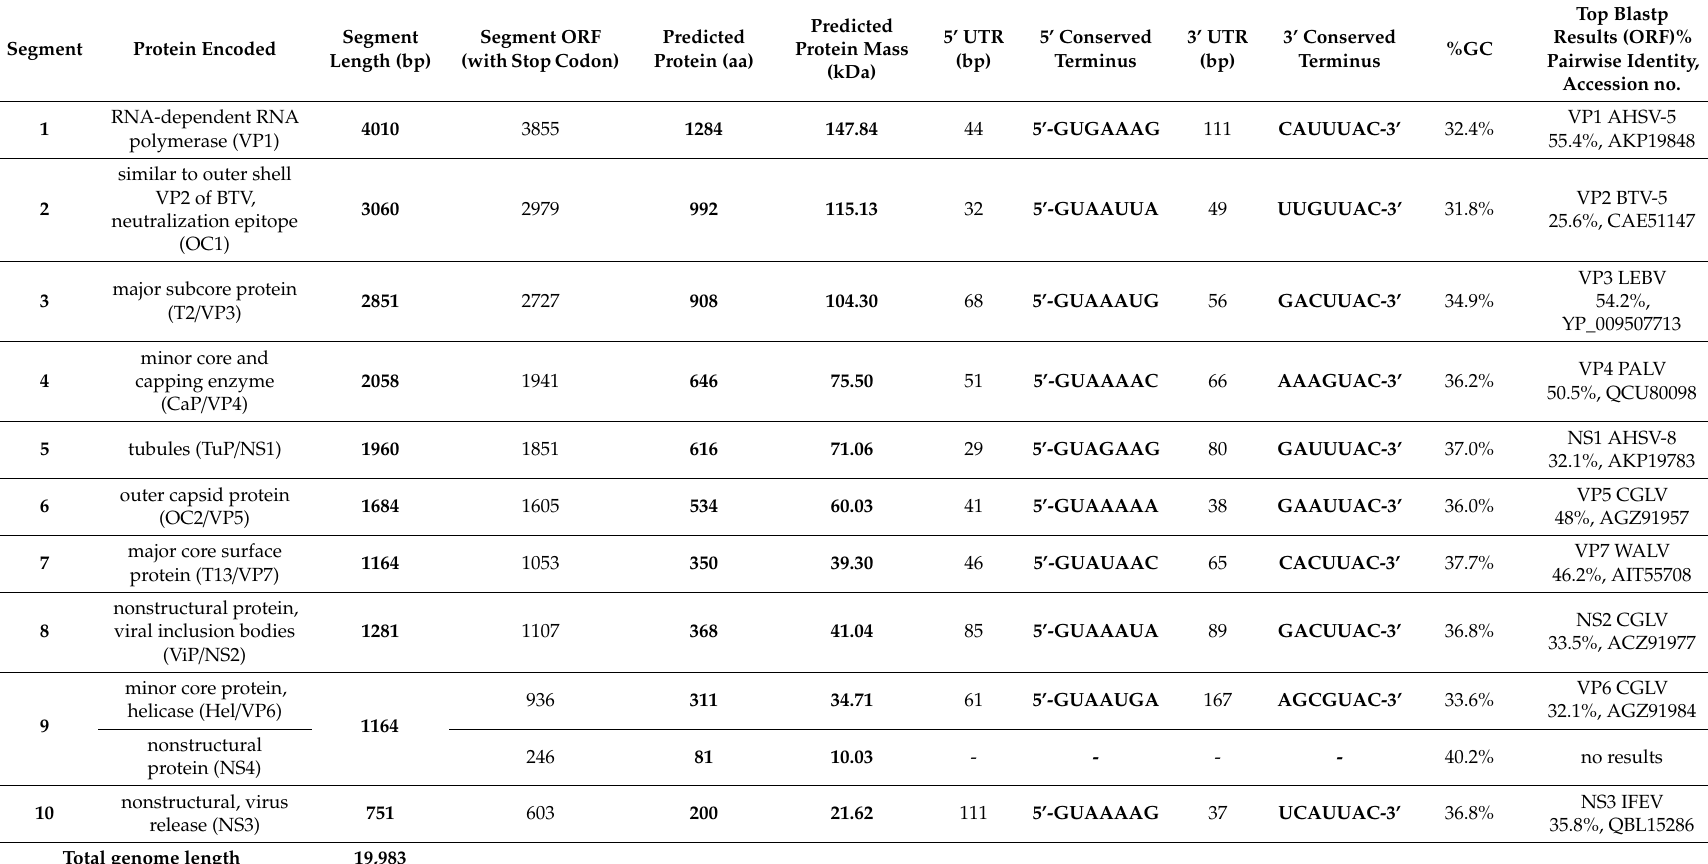
Table 1. Characteristics of the dsRNA genome segments of LEAV